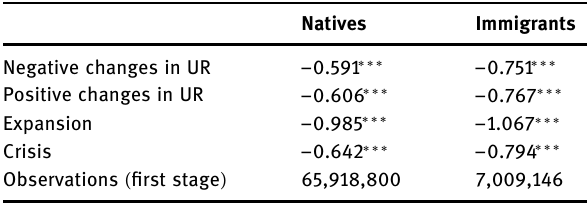
Table 7: Wage cyclicality along the business